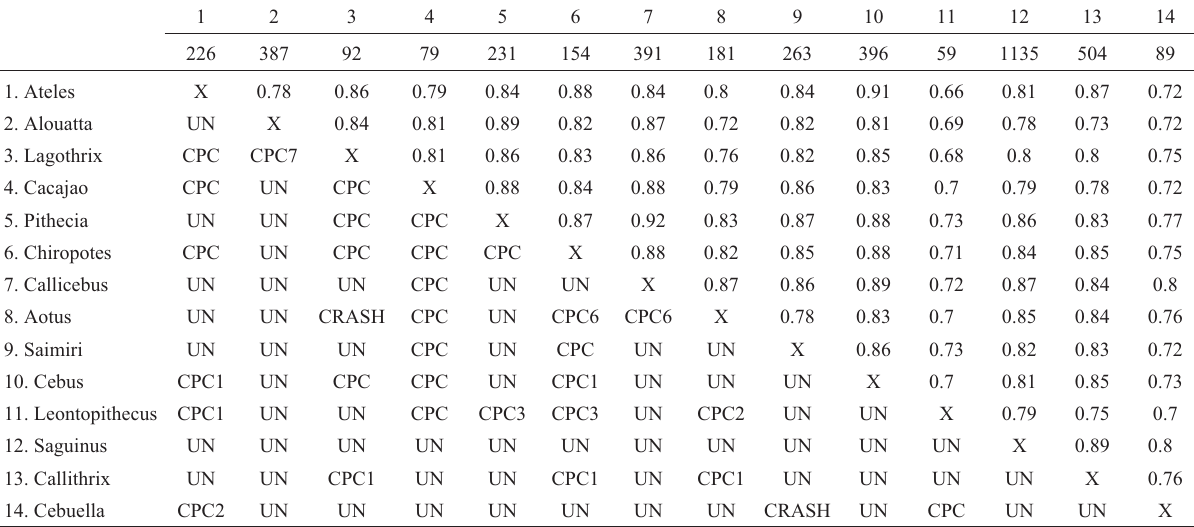
Table 1 - CPC results between each pairwise comparison of the fourteen Neotropical primate covariance matrices shown below the diagonal. Comparisons are rated as equal (EQ), proportional (PROP), sharing all principal components (CPC), sharing the first X principal components (CPCX), and unrelated (UN). The Random Skewers results are presented above the diagonal. Sample sizes are shown in the second row.